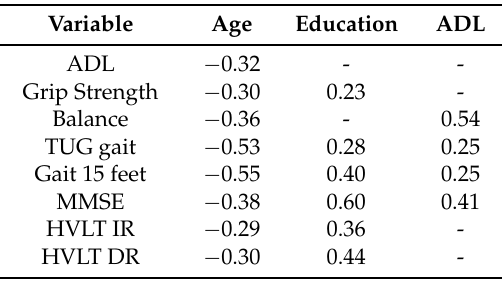
Table 3. Partial correlation matrix between the physical and cognitive variables, controlled for age